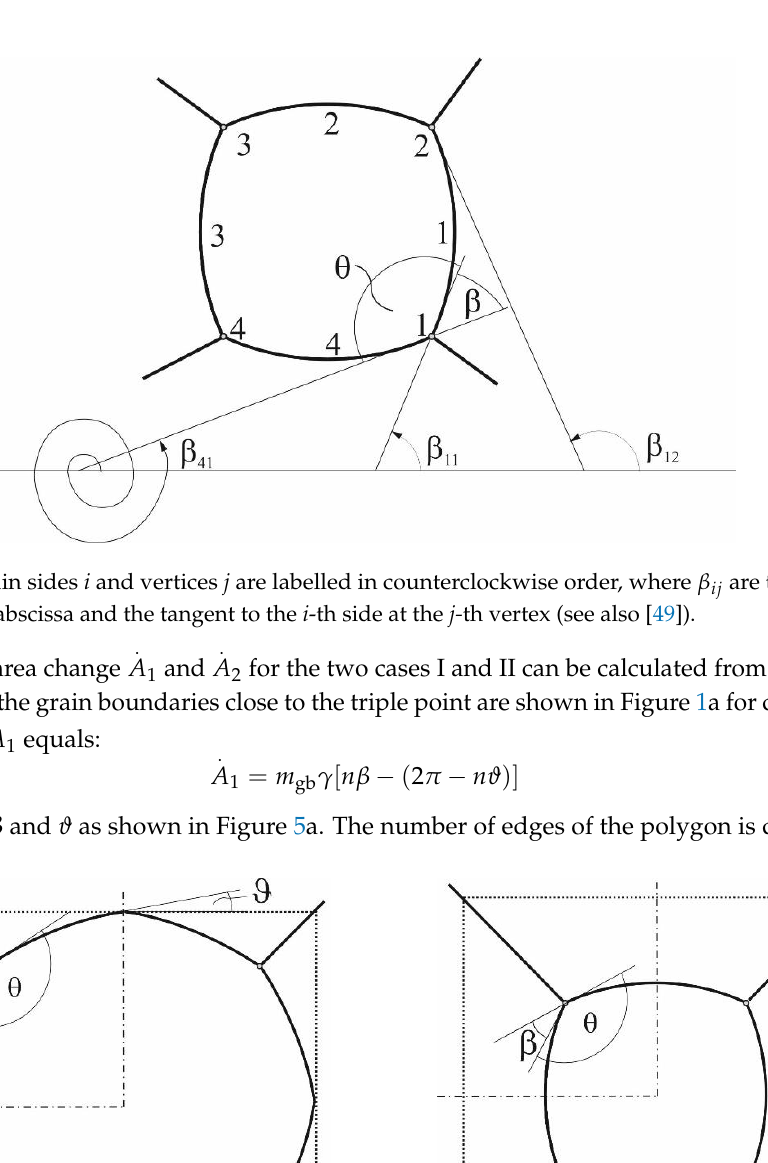
Figure 5. Shrinking of the initially quadratic grain: ( a ) Case I: The centers of the grain boundaries are fixed; thus, an edge formation with angle  can occur at this center. ( b ) Case II: The centers of the grain boundaries can move due to symmetric boundary conditions and the initially quadratic grain shrinks and eventually disappears.